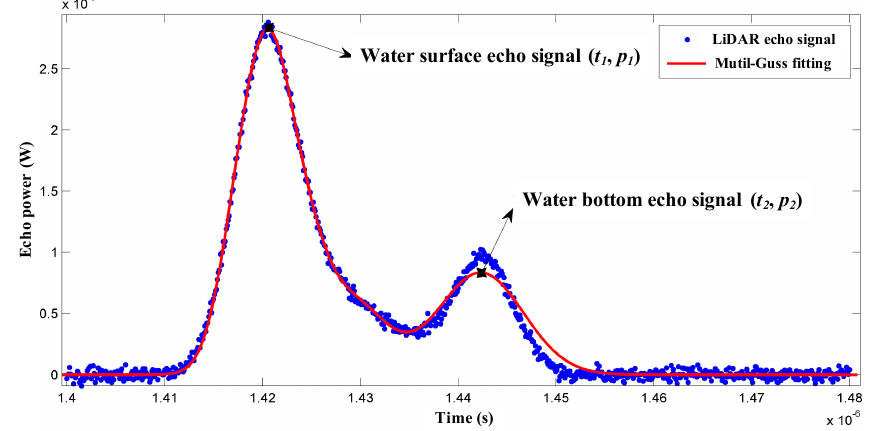
Figure 5. LiDAR echo signal detection based on the fitting of Gaussian function.